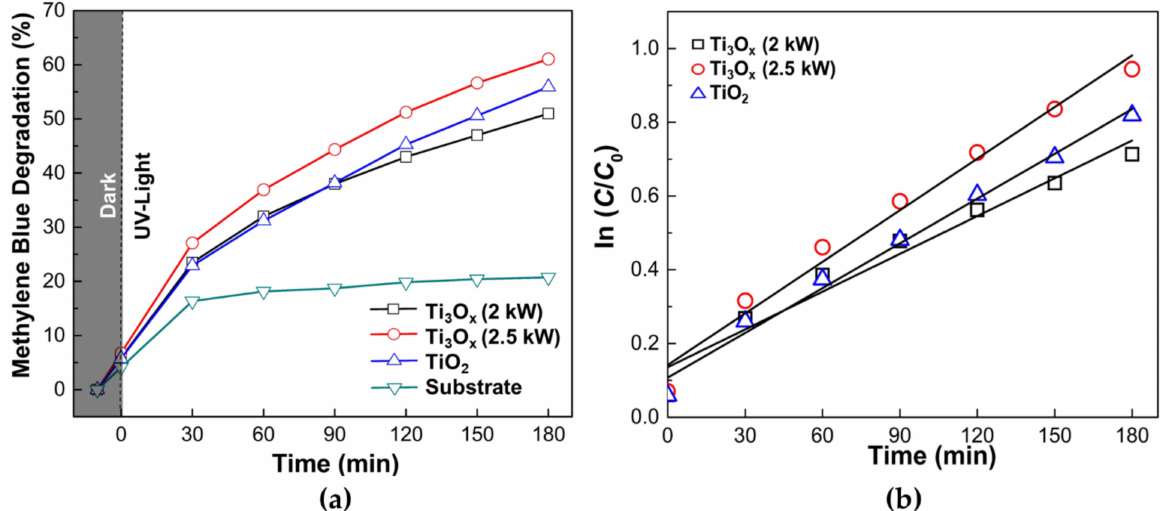
Figure 8. Photocatalytic activity of Ti 3 O x thin film samples in the function of the irradiation time in MB solution. ( a ) Methylene blue degradation percentage. ( b ) First-order reaction rate of thin films samples with